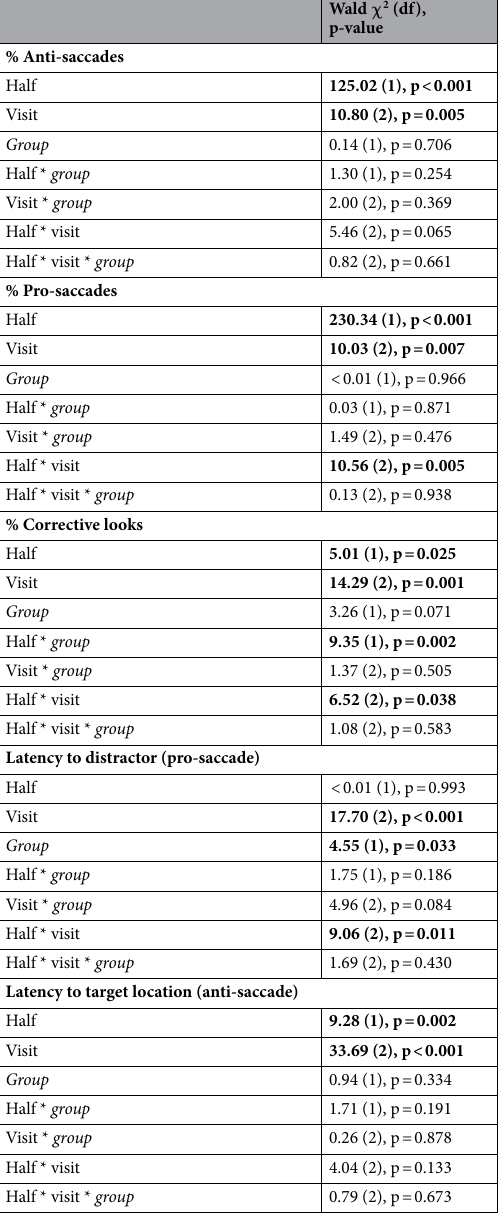
Table 2. Summary of GEE Model Effects including long-term user group (high and low users) and visit (12 months, 18 months, and 3.5 years), and task half (first, second) as predictors of the Anti-saccade Task outcome measures. The analysis included 14 LUs and 24 HUs. Significant results are in